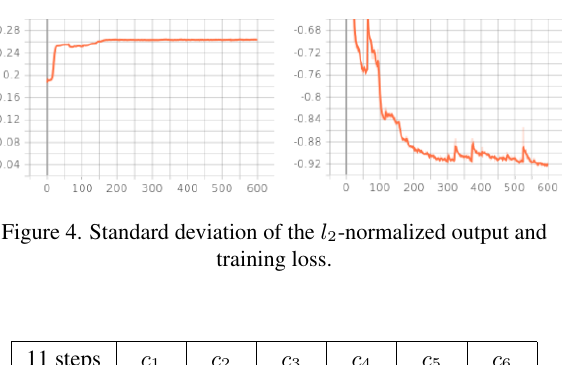
Figure 3. Examples of embeddings generated with principal component analysis (PCA). The six different colors represent the crop types. A) gives an overview of the raw data. B) shows the result after pre-training with SimSiam and Aug1. Here it is already possible to differ between clusters. C) shows the last step and the embeddings after fine-tuning with labels.